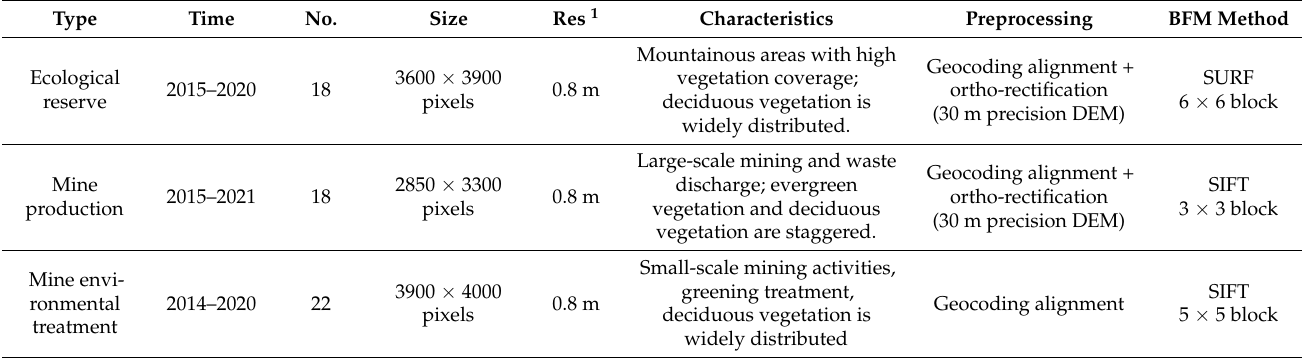
Table 1. Overview of the experimental